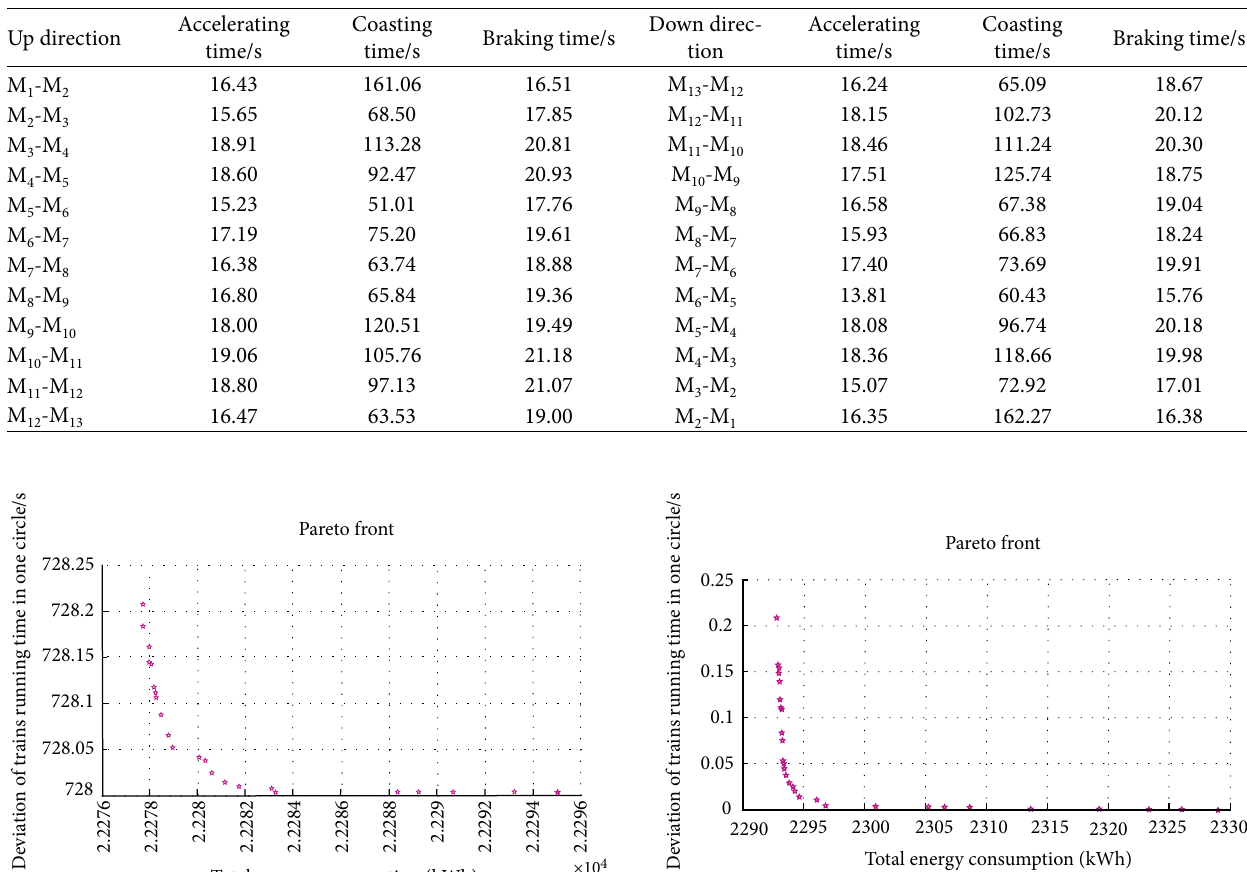
8: The optimized running time of three phases in each